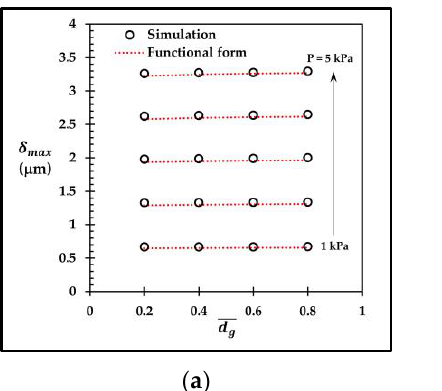
and ∆𝜎 2 . ,𝐴𝐺−𝑇𝑜𝑝 ,𝐴𝐺−𝑇𝑜𝑝